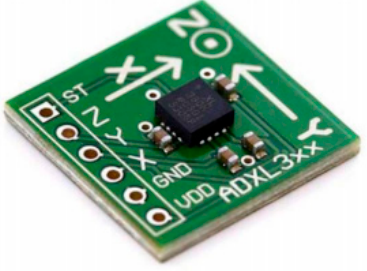
Figure 8. The ADXL335 3-axis ACC with a three-output analog pin x, y, and z [19–21].